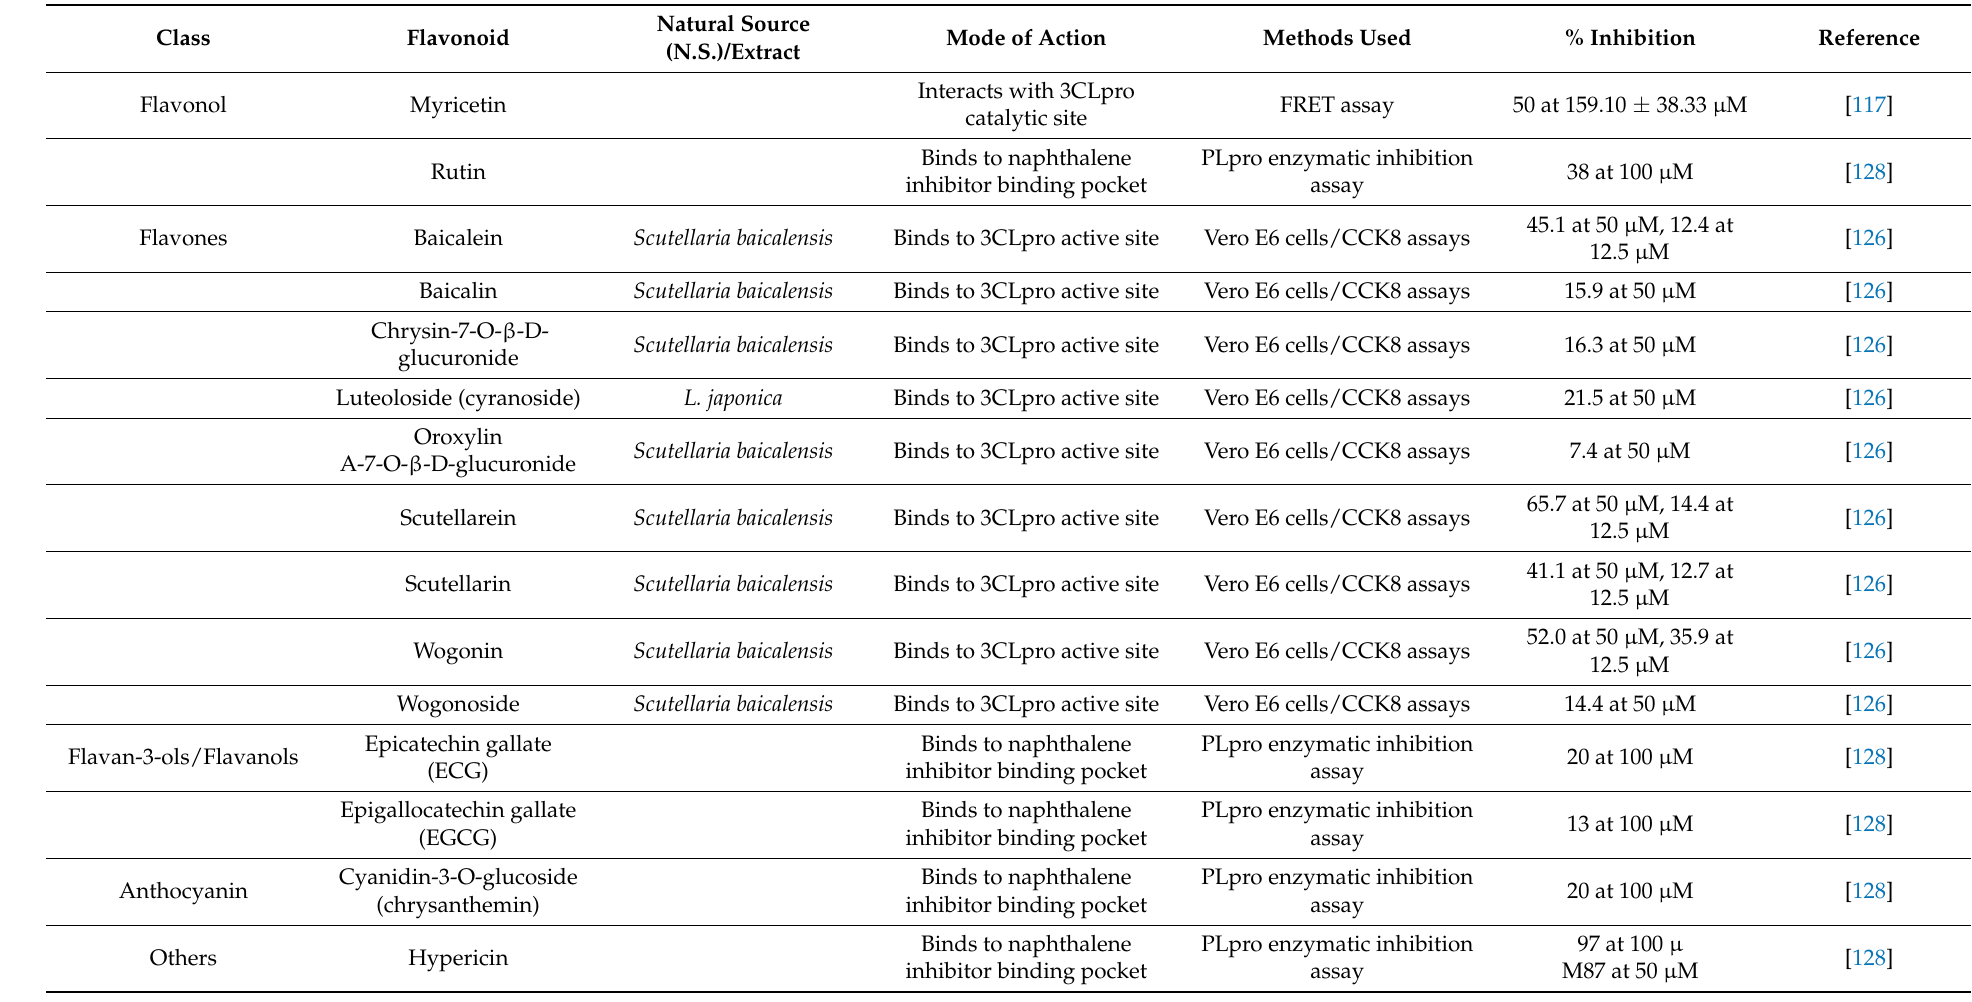
Table 2. Flavonoids with antiviral activities reported against SARS-CoV-2 PLpro using in vitro methodologies segregated according to